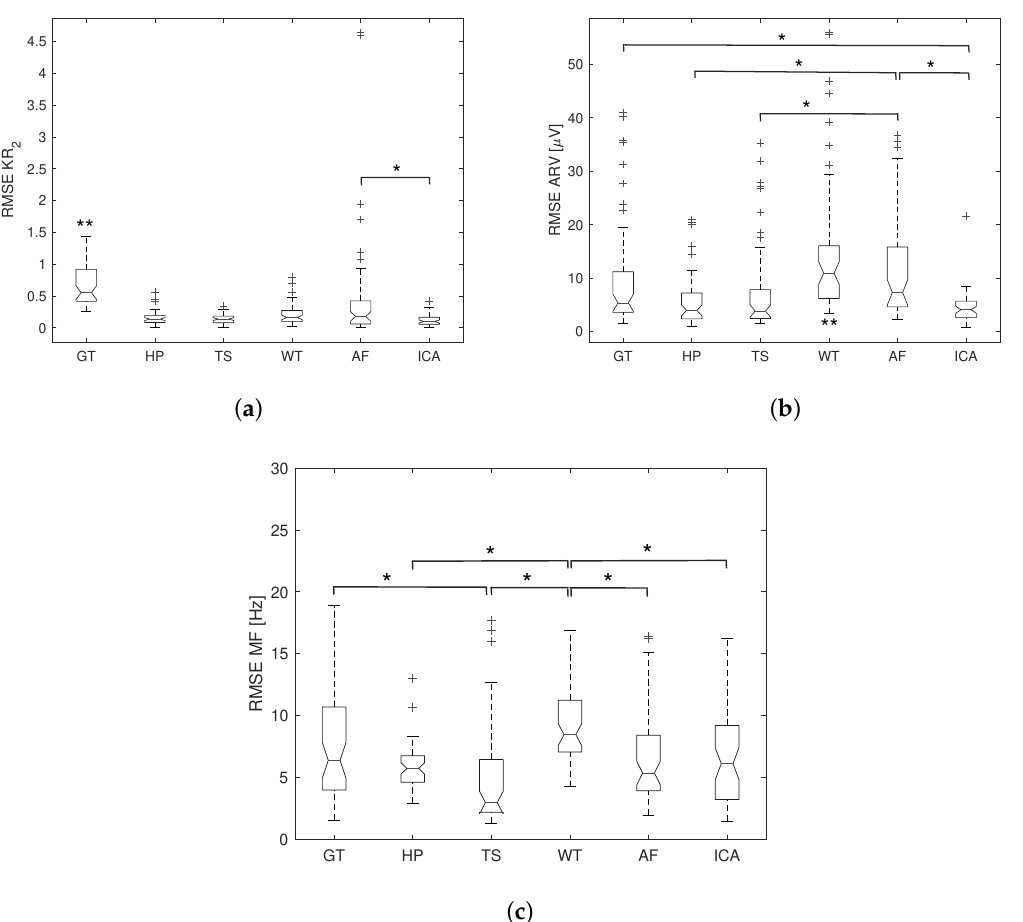
Figure 9. Boxplot of the RMSE results for different ECG removal methods with dysrhythmia ECG interference: ( a ) RMSE in KR 2 ; ( b ) RMSE in ARV; ( c ) RMSE in MF. Data are presented as median, the first and third quartiles, and the upper and lower adjacent. + indicates the outliers (whisker length = 1.5). ** indicates significant ( p < 0.05) difference from all other methods, and * indicates significant ( p < 0.05) difference between two